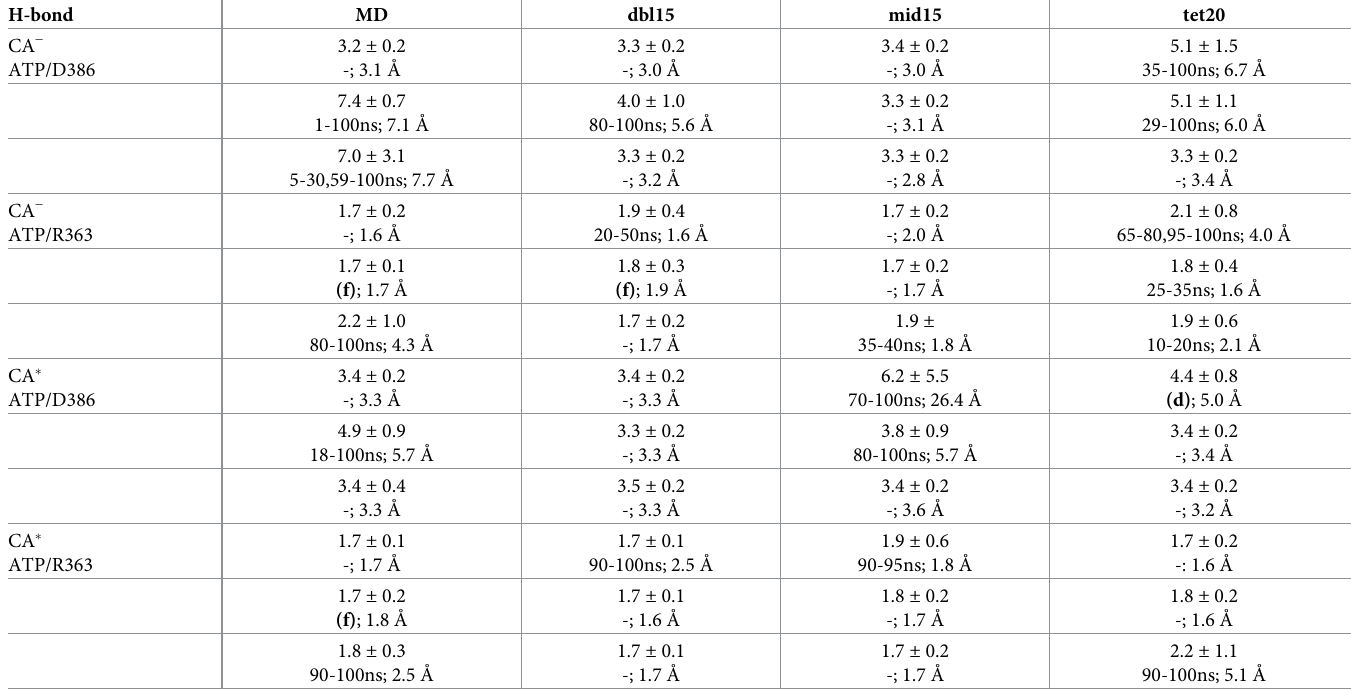
Table 4. Average distances ( Å ) between D386 sidechain (O δ 1-2) and the phosphate group of ATP, as well as the minimum distance value between the H η hydrogens of the R363 sidechain and the O γ of ATP, calculated along the replicated MD and TAMD trajectories. In the second line, the dissociation intervals are given along with the final distance value. The dissociation was supposed to take place for distances larger than 3 Å . If no dissociation occurs, a dash sign is written. (d) Equilibrium between a partially dissociated and bounded positions of ATP. (f) Few isolated dissociation events take place along the